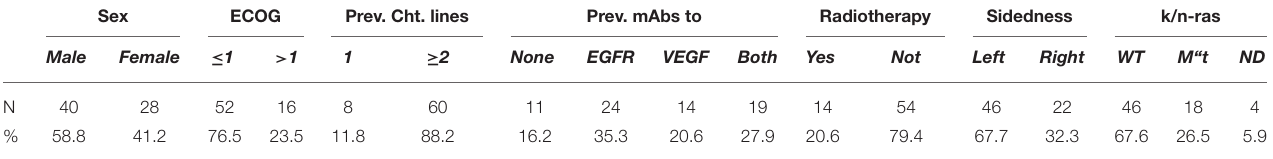
Sex ECOG Prev. Cht.